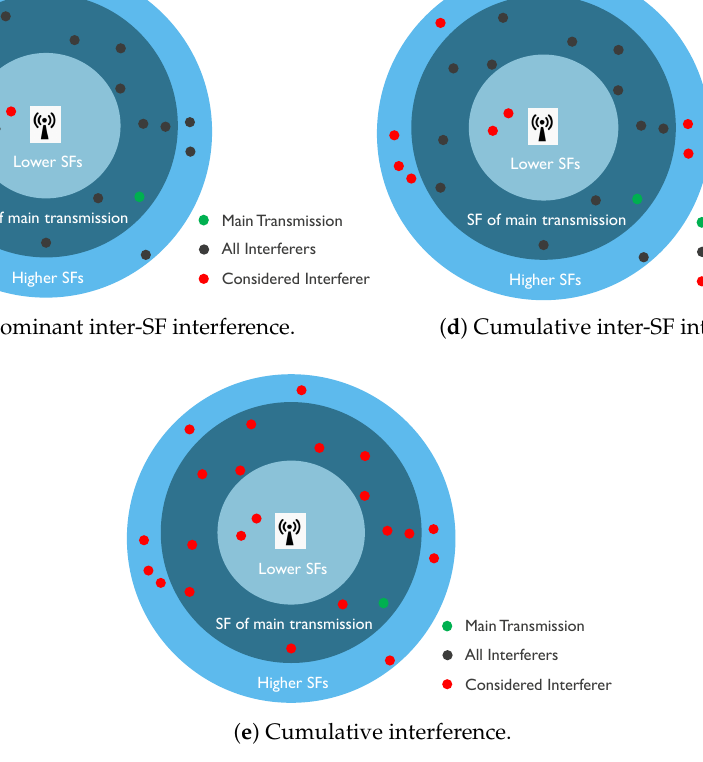
Figure 7. Interference scenarios that are taken into account in LoRaWAN